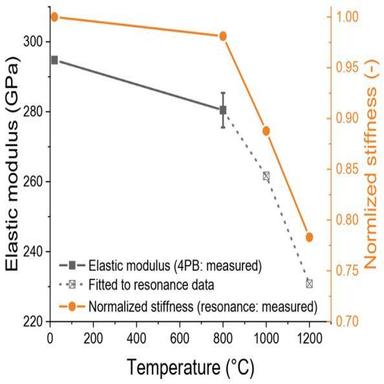
Elastic modulus as function of temperature.